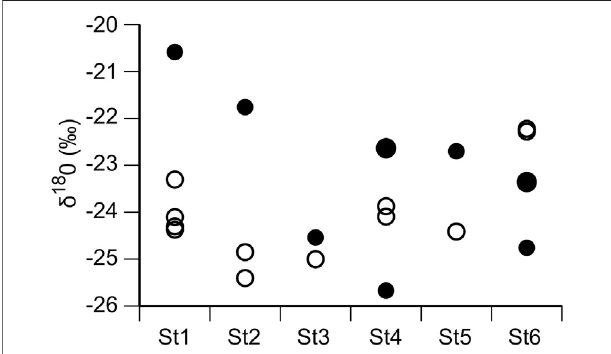
FIGURE 5 | δ 18 O of snow of the seasonal snow (solid circle) and the glacial ice (open circle) at site 1 – 6.